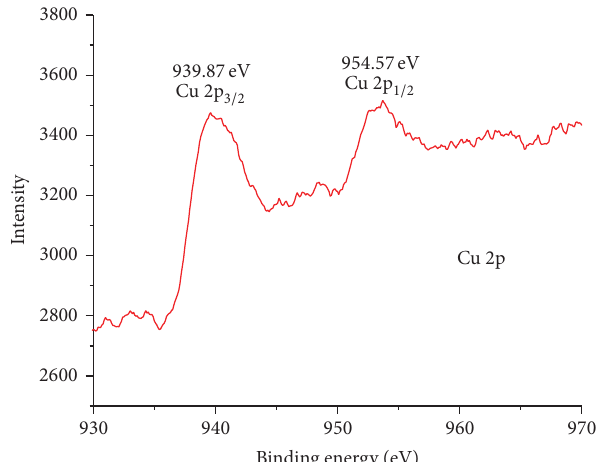
Figure 3: X-ray diffraction pattern of CuO NPs synthesized using aqueous extract of Saraca indica leaves.